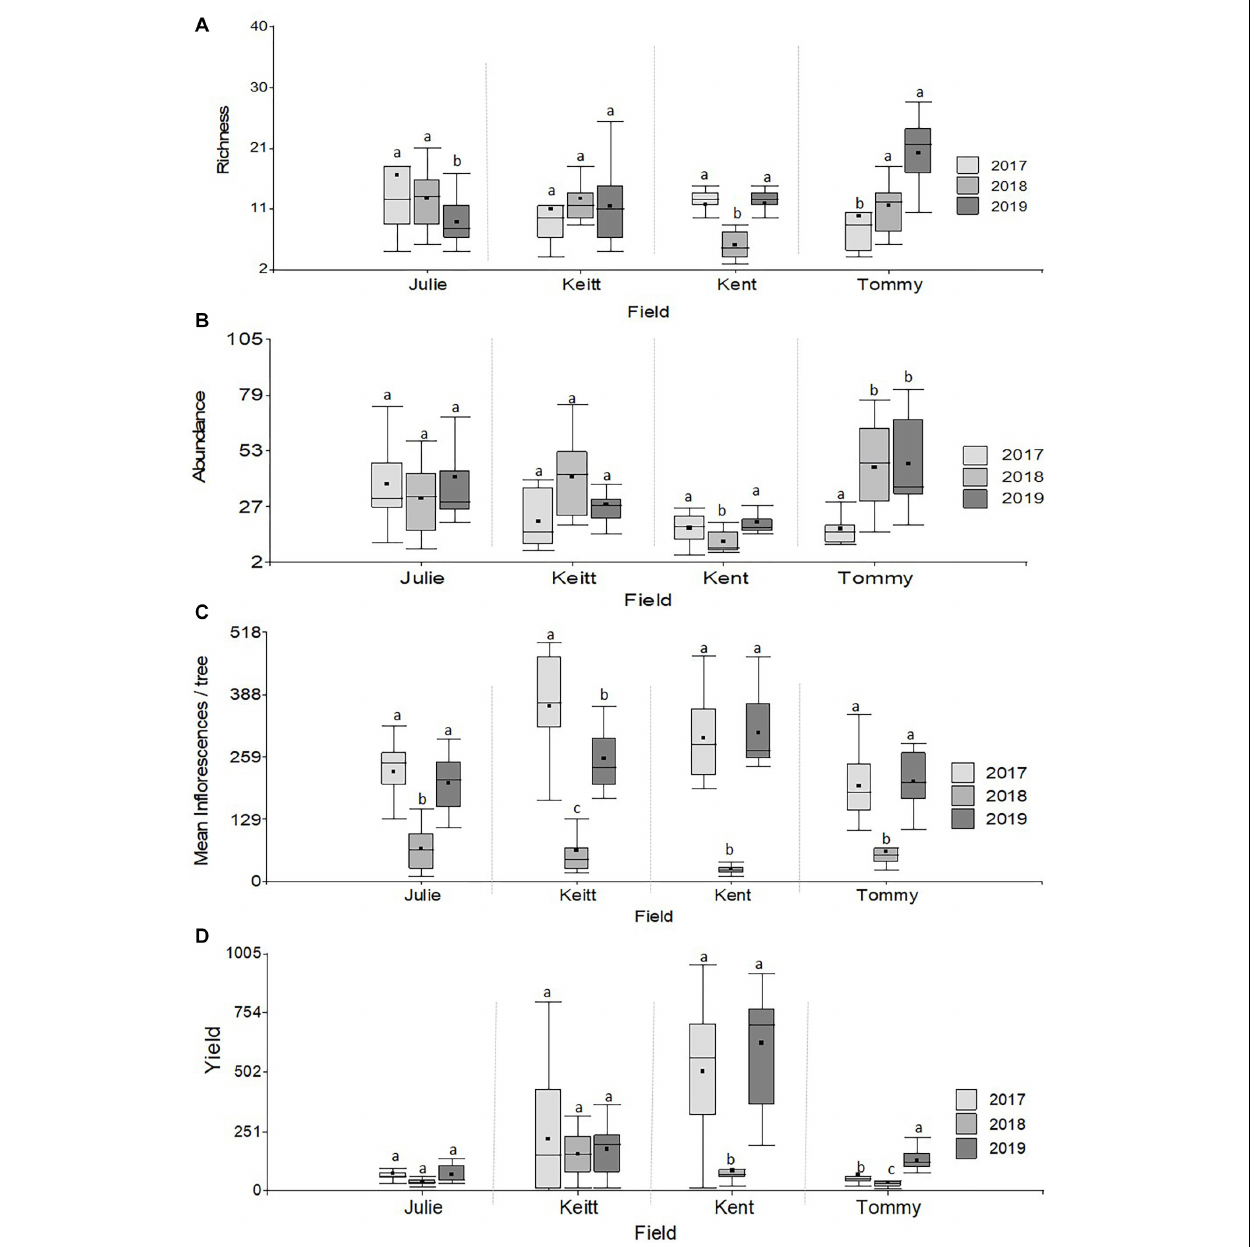
FIGURE 5 | Boxplots illustrating differences in variables related to the state of pollinator communities experienced by trees (insect richness and abundance) and variables related to tree reproductive effort (number of inflorescences and fruit yield) in M. indica in 2017, 2018, and 2019. (A) Richness, (B) Abundance, (C) Yield (kg), (D) Number of Inflorescences/tree. Different letters within a field indicate significant differences among years following Repeated measures ANOVAs analyses ( Table 3